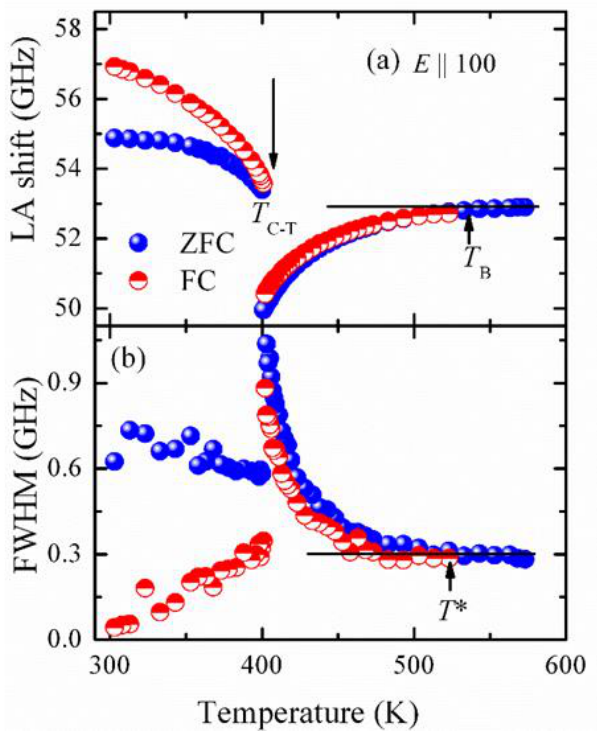
Figure 4. The temperature dependences of ( a ) frequency shift ( υ LA ) and ( b ) FWHM ( Γ LA) of LA phonon mode of 100-BT single crystals measured in ZFC (blue solid symbols) and FC (red solid half-filled symbols) processes